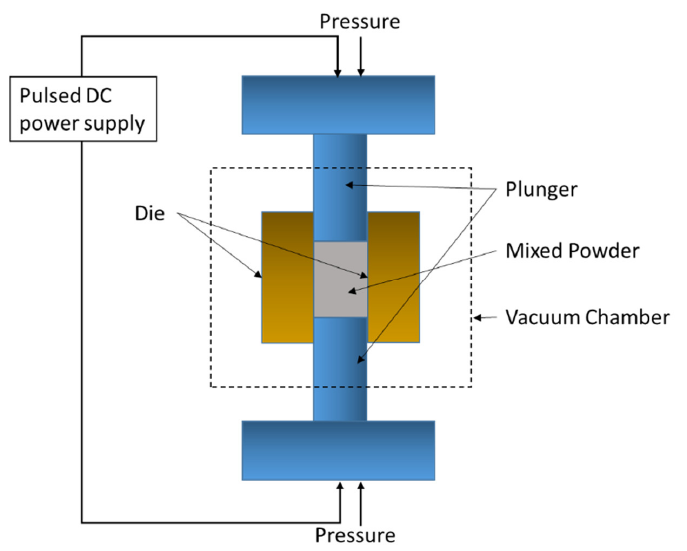
Figure 10. Spark plasma sintering (SPS) schematic setup.